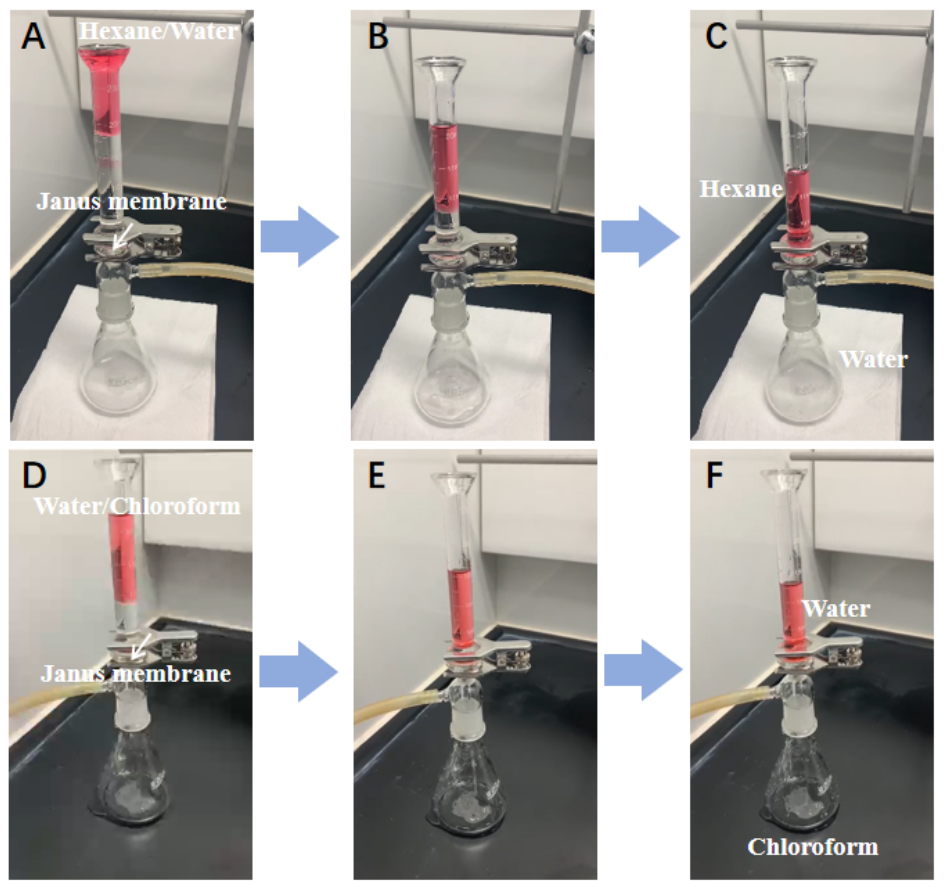
Figure 4. Optical photographs of ( A – C ) hexane (light oil)/water separation and ( D – F ) water/chloroform (heavy oil) separation process.